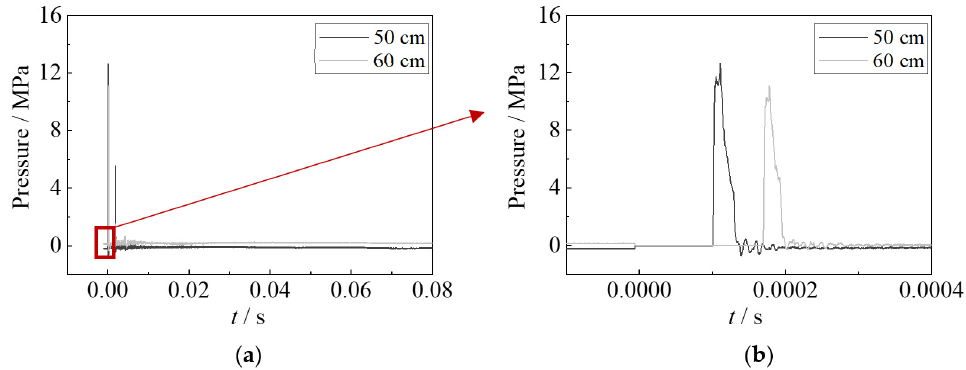
Figure 7. Impulsive pressure of underwater explosion for 5 g TNT. ( a ) Whole process. ( b ) Shock wave.